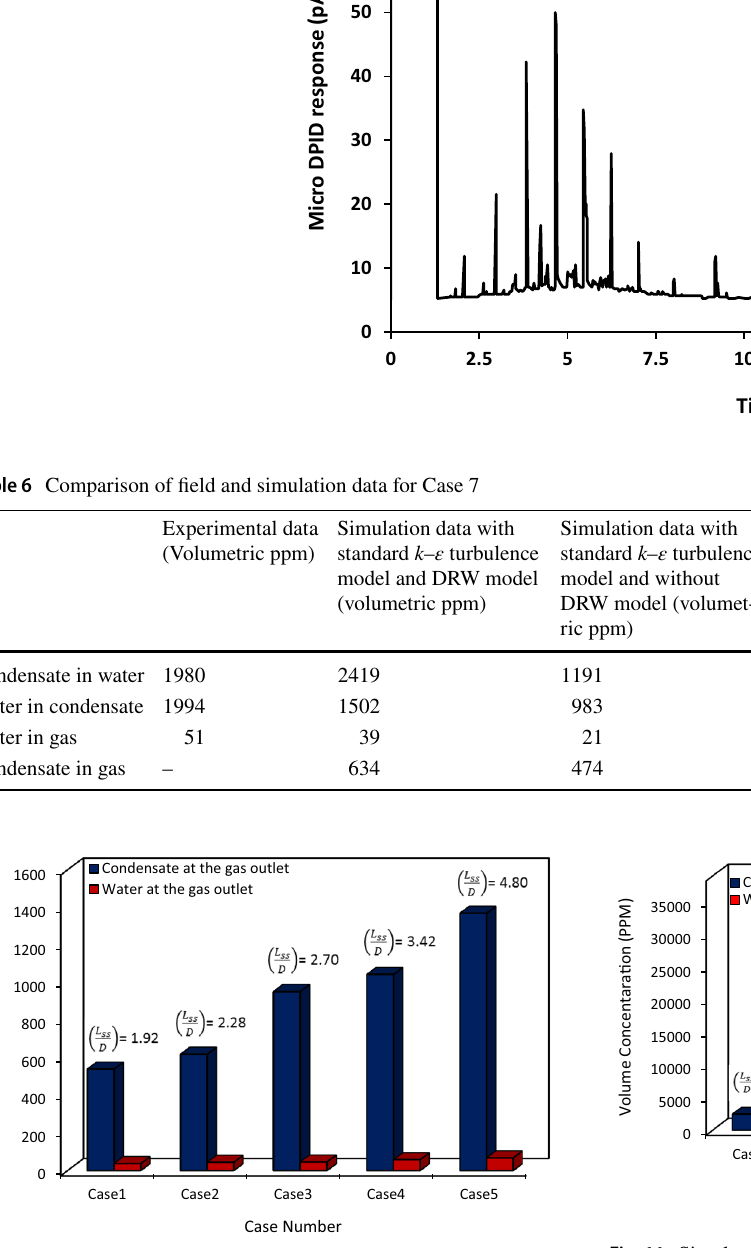
Fig. 10 Simulated mass distribution of condensate and water droplets at the gas outlet of Cases 1–5